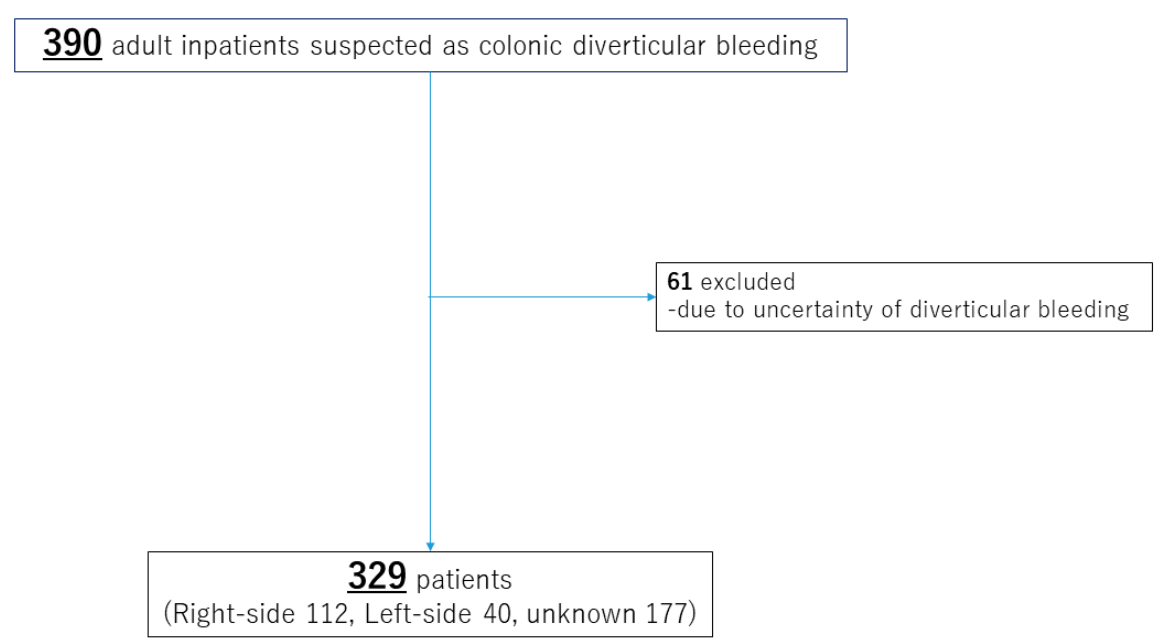
Figure 1. Flowchart of selecting subjects.